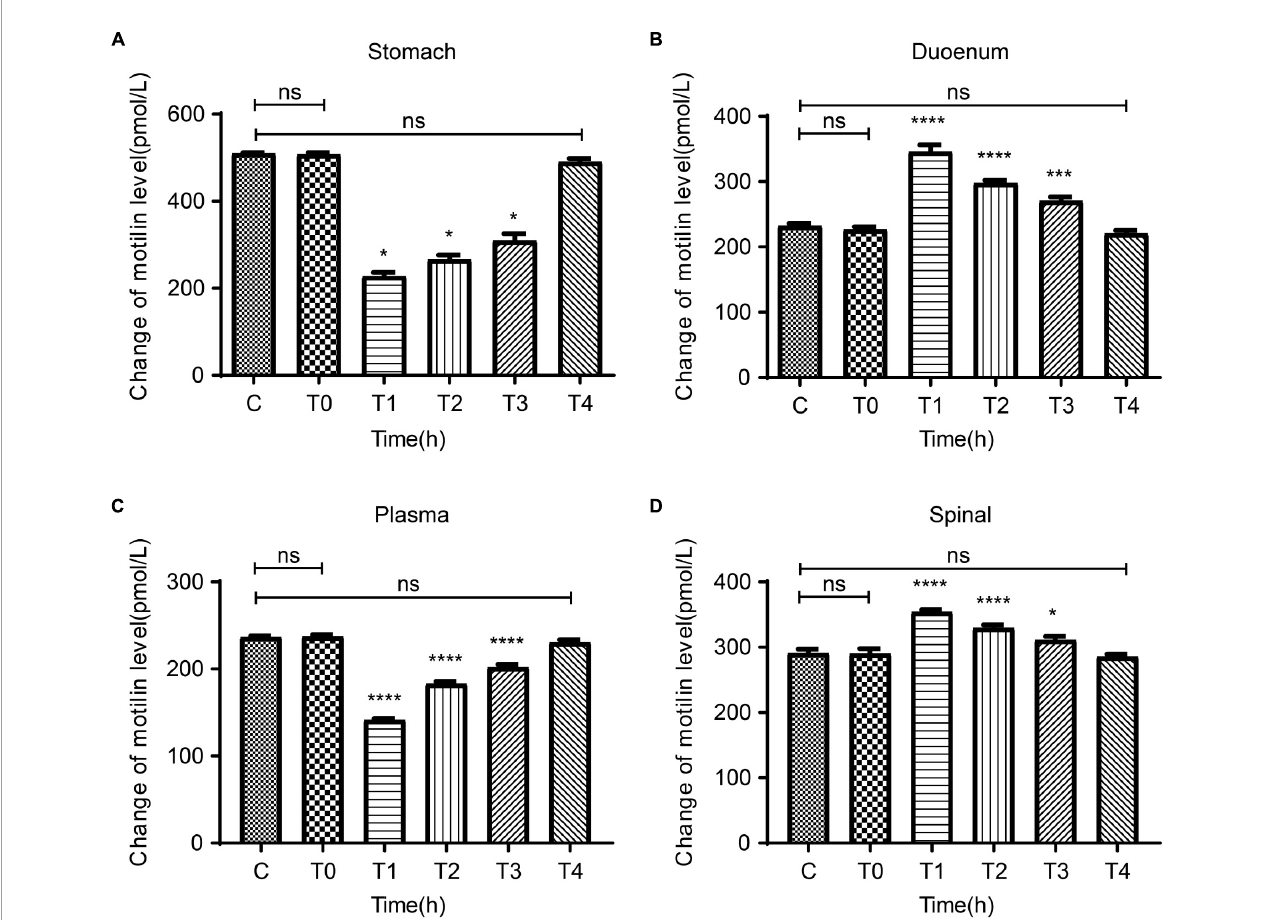
FIGURE4 Dynamic changes in motilin (MTL) levels before surgery (T0) and at 2 h (T1), 24 h (T2), 48 h (T3), and 72 h (T4) after surgery in the acute incisional pain model (P group) and controls (C group). (A) Stomach. (B) Duodenum. (C) Plasma. (D) Spine cord. n = 6 rats/group/time point. ns, not significant; * P < 0.05, *** P < 0.001, and **** P <